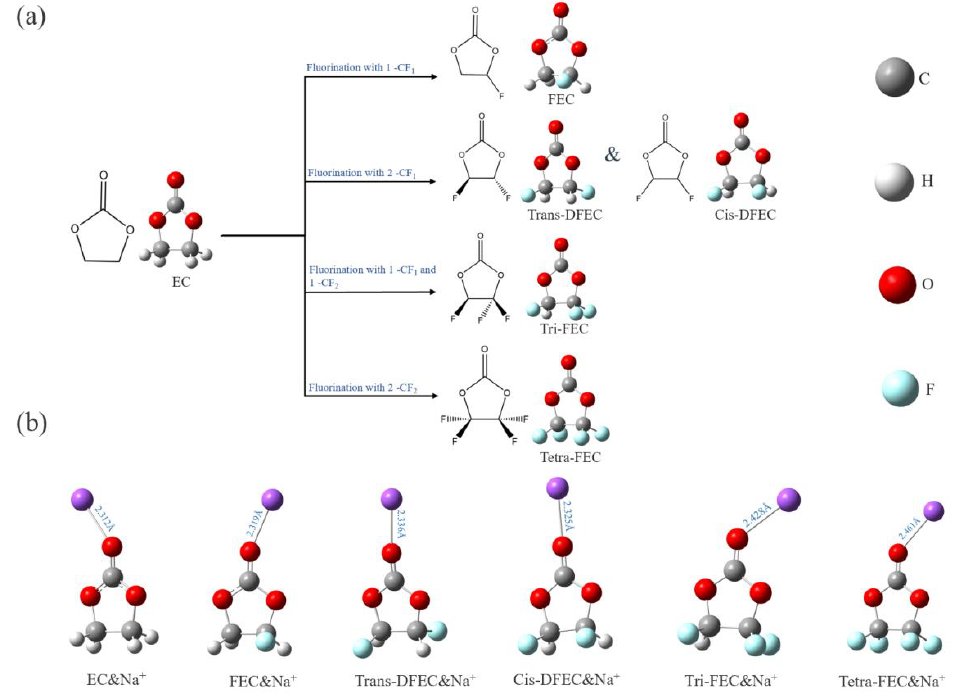
Figure 7. Design logic flow of EC fluorination ( a ) and the optimized structure of Na-ion with those molecules ( b ).